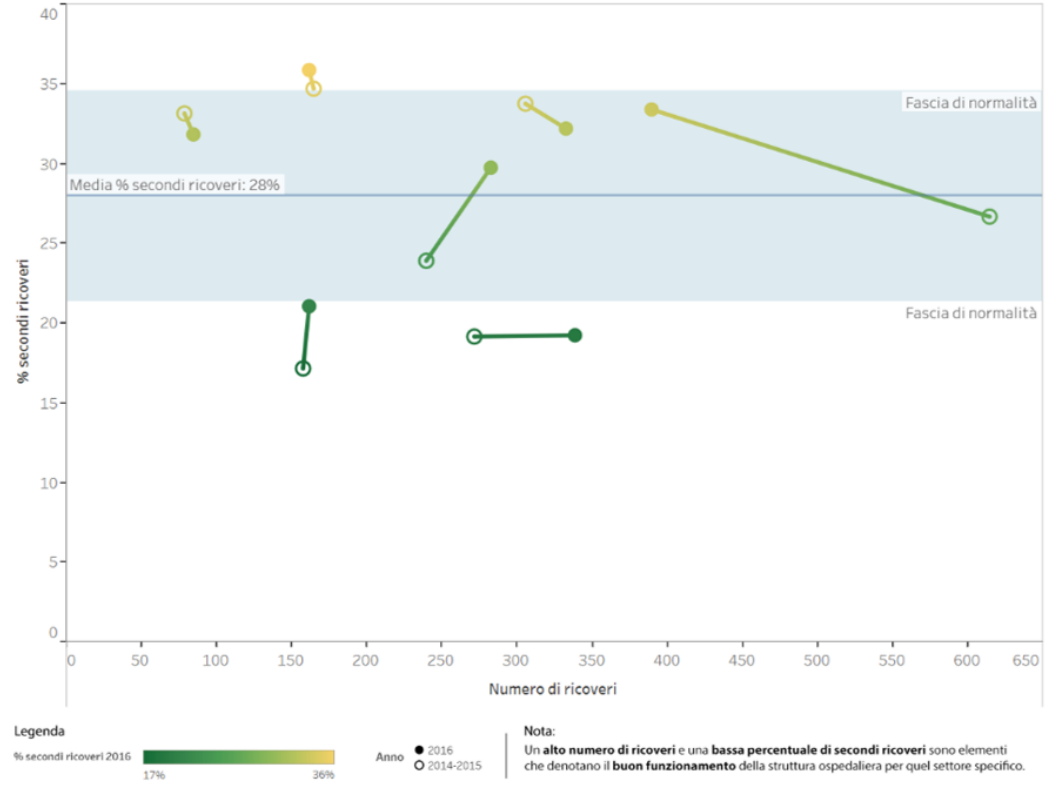
Figure 1. Visual chart showing comparison of two consecutive years (two extremes of each gradient colored stick) of number of inpatients stays ( x -axis) and percentage of second inpatients stays ( y -axis) for same disease in the same hospital (each stick is a hospital). Upward sticks denote worsening performance (increase of second inpatient stays for same disease); downward stick denotes improving performance (decrease of second inpatient stays for same disease). Gradient from green (lower % of second inpatient stays) to yellow (higher % of second inpatient stays) depicts with the color dimension the same increase/decrease in data of the stick